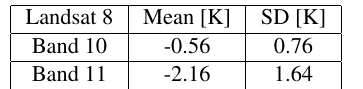
Figure 7: Example of a cloud product with each pixel categorized as cloudy (red), clouds in the vicinity (blue), or cloud free (black). Note that green pixels are pixels in the surround of the image.